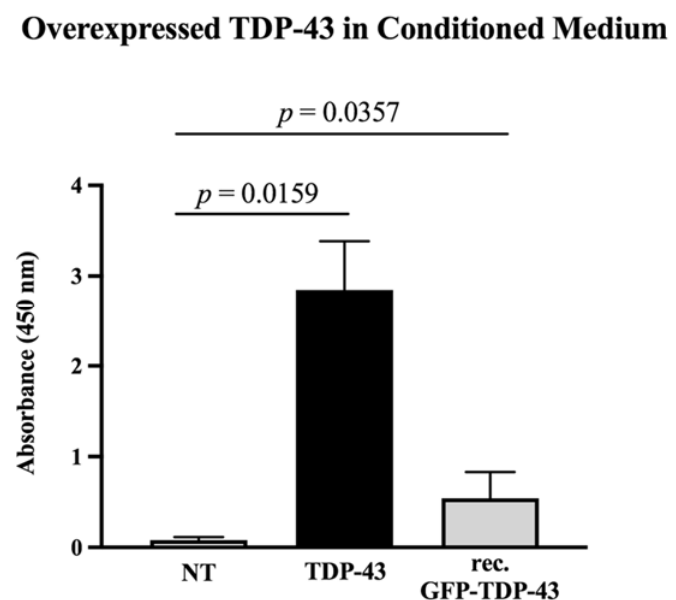
Figure 2. Detecting overexpressed wtTDP43-6 × His in conditioned medium. ELISA shows the presence of wtTDP43-6 × Hisinthemediumoftransfectedcellsonly. Thespecificityoftheantibodyusedinthesandwich ELISA was validated by incubating with 1.0 µ g / mL of purified, recombinant GFP-wtTDP43-6 × His that was available in our lab, serving as a positive control. NT: HEK293T only treated with transfection agent; TDP-43: wtTDP43-6 × His; rec. GTH: recombinant GFP-wtTDP43-6 × His. Statistical test: Mann–Whitney non-parametric t -test. N =